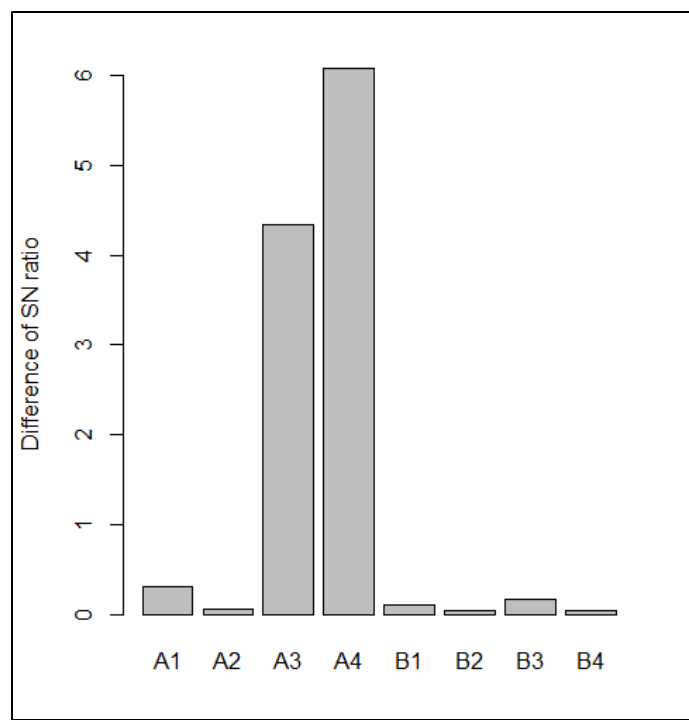
Figure 5. Effect of A and B factors on the SN ratio.